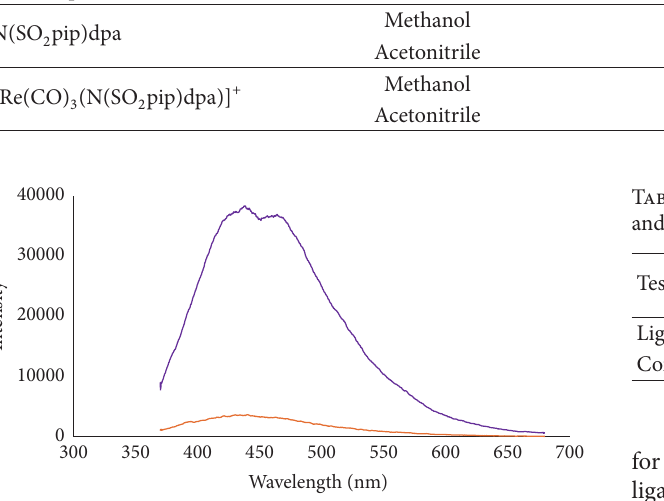
Table 7: Excitation and emission wave lengths of N(SO 2 pip)dpa and [Re(CO) 3 (N(SO 2 pip)dpa)] + in methanol and acetonitrile. Test sample